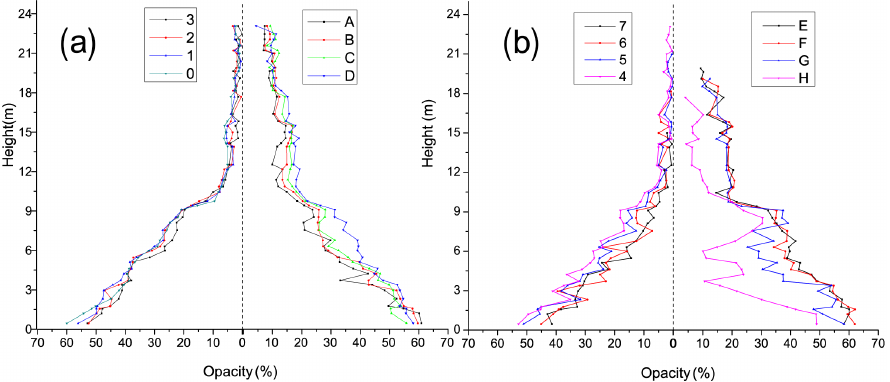
Figure 3. Vertical opacity profiles of dust devils.